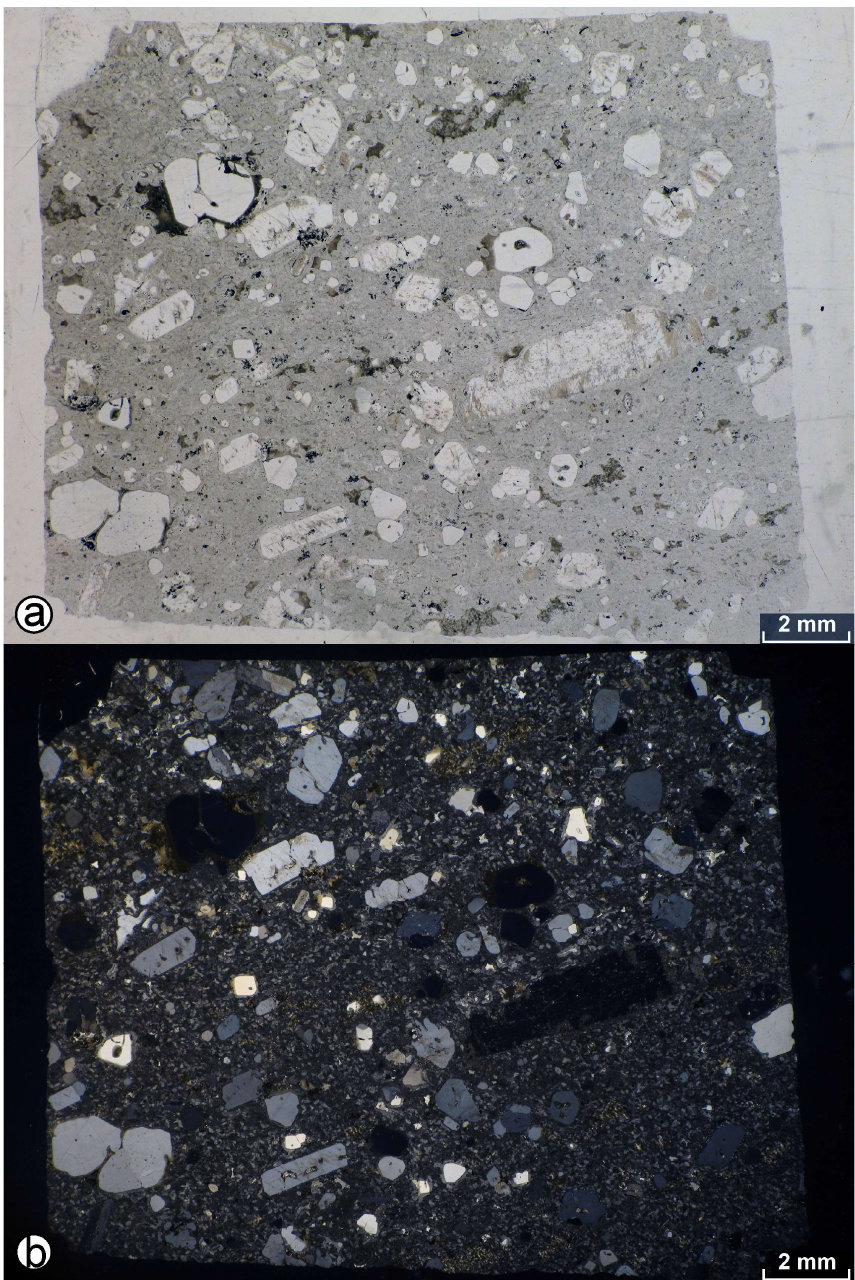
Figure 6. Thin sections of sample AK220617-1_2. ( a )—transmitted light, ( b )—crossed nicols.